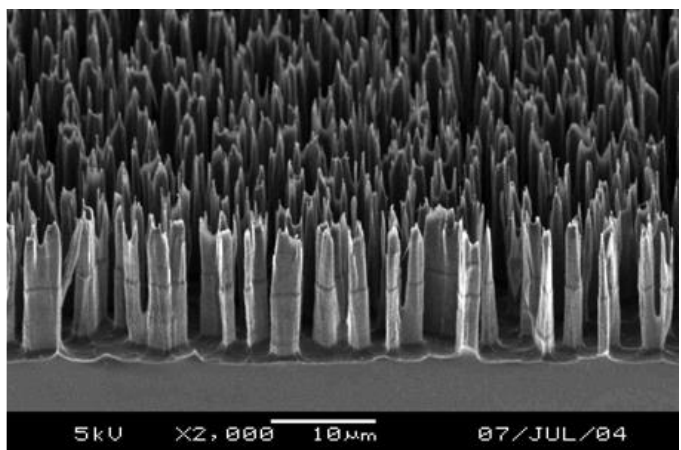
Figure 10. Schematized mechanism of the plasma nano-texturing of polymers. ( a ) plasma ignition, etchant species producing volatile species; ( b ) during plasma etching metal clusters stick on the sample, masking the surface; ( c ) Etching proceed though the nanomask.